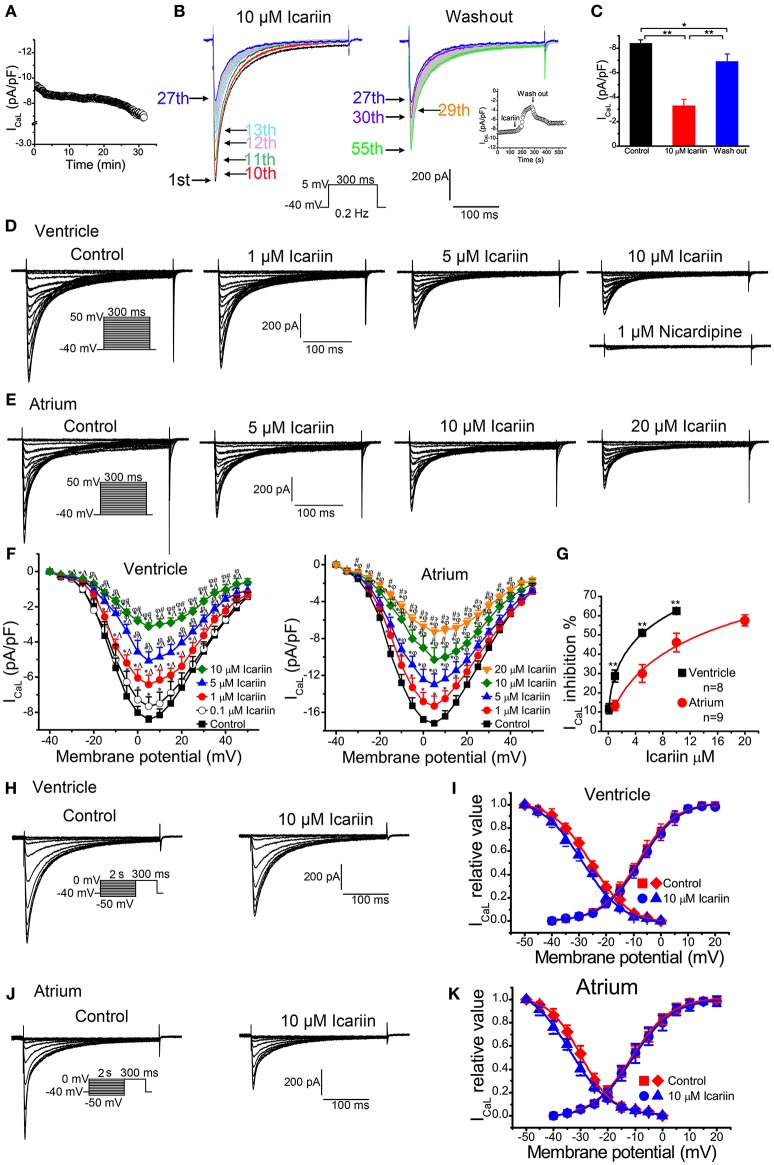
Effects of icariin on ICaL in LVMs and LAMs. (A). Time course of the ICaL run-down phenomenon in LVMs under the control condition, n = 5 cells/2 rabbits. ICaL were evoked by 300-ms depolarization pulses ranging from a holding potential of −40 mV to 5 mV at 0.2 Hz. (B). Consecutive recordings of ICaL evoked by a 300-ms depolarization from a holding potential of −40 mV to 5 mV at 0.2 Hz. The 1st sweep represents the control condition, the 2nd to 27th sweeps represent the period in which icariin exerted its effects on ICaL, and the 27th–55th sweeps indicate the period in which the effects of icariin on ICaL were reversed. The inset represents the time course of the entire process, including the control condition, the icariin perfusion period, and the icariin wash-out period. The entire process was conducted during the stabilization period. ((C). Summary data for the mean current densities of ICaL in the control condition, the icariin perfusion period, and the icariin wash-out period, n = 10 cells/4 rabbits. * and **p < 0.05 and 0.01. (D). Representative current recordings of ICaL in LVMs after sequential applications of 1, 5, and 10 μM icariin. (E). Representative current recordings of ICaL in LAMs in the absence and presence of 5, 10, and 20 μM icariin. (F). Current-voltage relationship of ICaL in LVMs (left; n = 13 cells/6 rabbits) and LAMs (right; n = 9 cells/5 rabbits) before and after the application of icariin. *p < 0.05 vs. control; ∧p < 0.05 vs. 0.1 μM icariin; φp < 0.05 vs. 1 μM icariin; #p < 0.05 vs. 5 μM icariin; ϶p < 0.05 vs. 10 μM icariin. (G). The dose-response relationships illustrating icariin-induced decreases in ICaL in LVMs and LAMs. * and **
p < 0.05 and p < 0.01 LVMs vs. LAMs. Data were fitted by the Hill equation. (H,J). Representative current recordings of ICaLevoked according to the steady-state inactivation protocol in LVMs (H) and LAMs (J) in the absence and presence of 10 μM icariin. (I). Steady-state activation (n = 14 cells/7 rabbits) and steady-state inactivation (n = 10 cells/4 rabbits) curves of ICaL in LVMs before and after icariin application. (K). Steady-state activation (n = 12 cells/7 rabbits) and steady-state inactivation (n = 10 cells/6 rabbits) curves of ICaL in LAMs before and after icariin application.